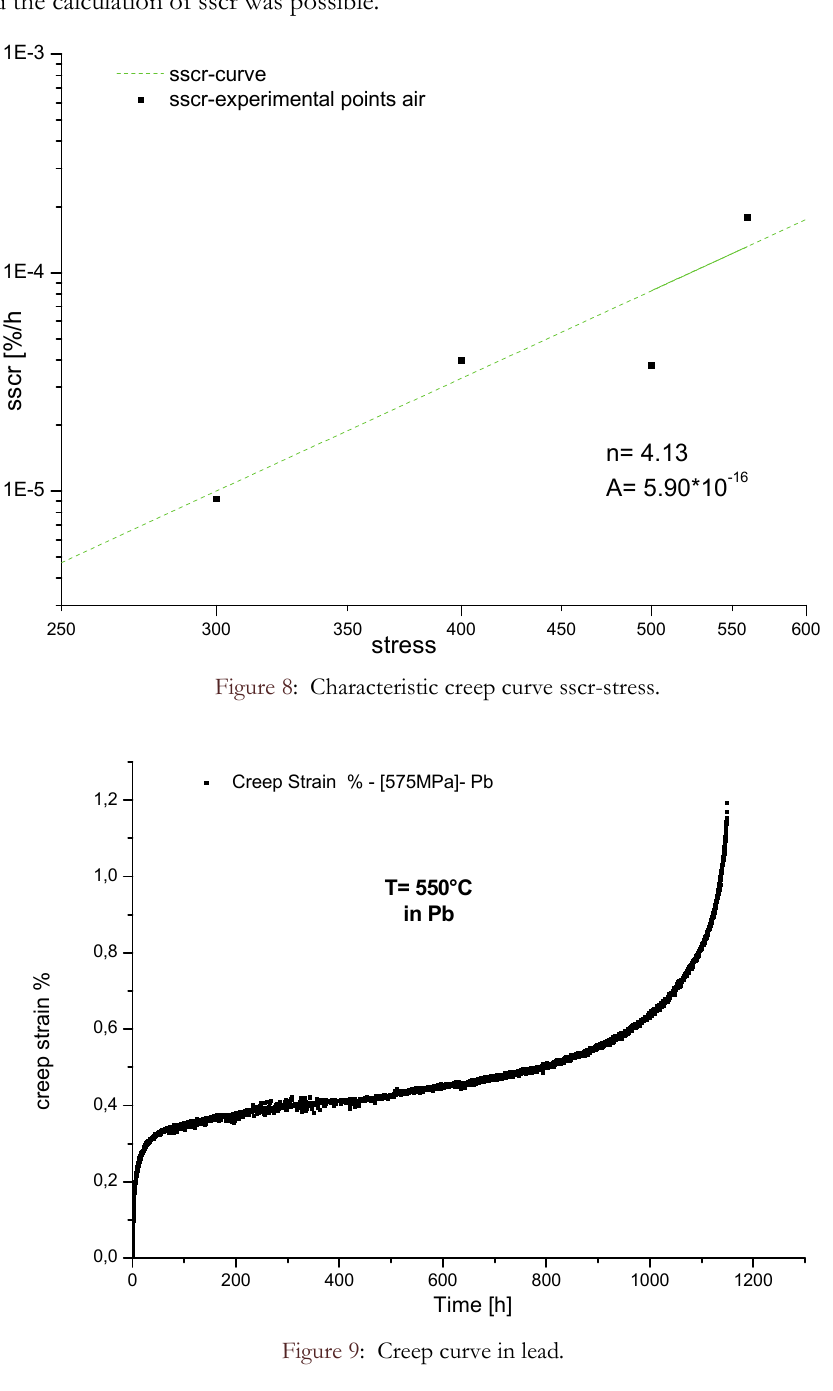
Figure 9: Creep curve in